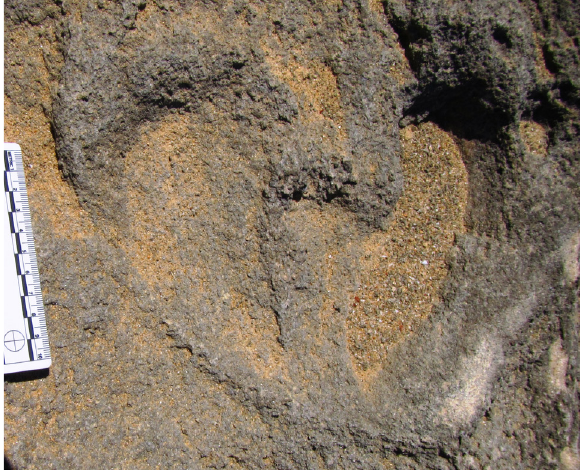
Scale bar = 10 cm Figure 8: Large artiodactyl track, probably made by long-horned buffalo, impressed upon infill layer of large elephant track on Megafauna Rock.